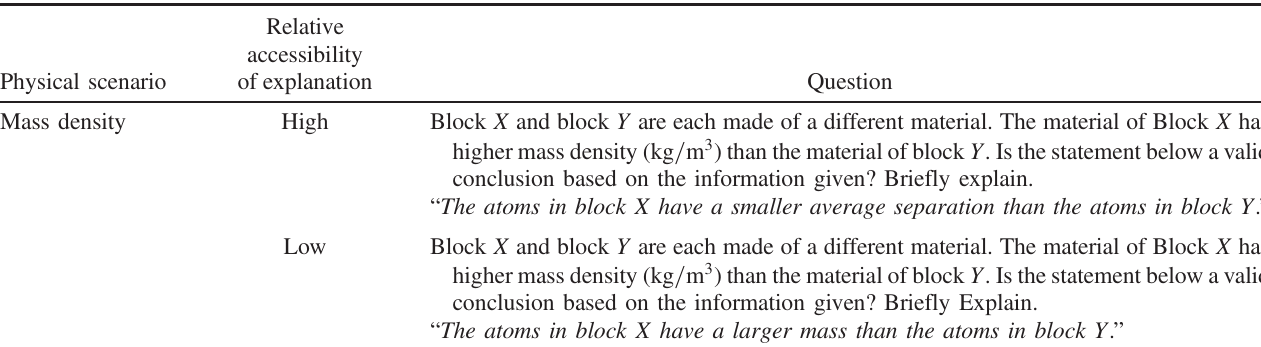
TABLE XIV. Experiment 2 short answer format questions. Participants answered either a high or low accessibility explanation for each